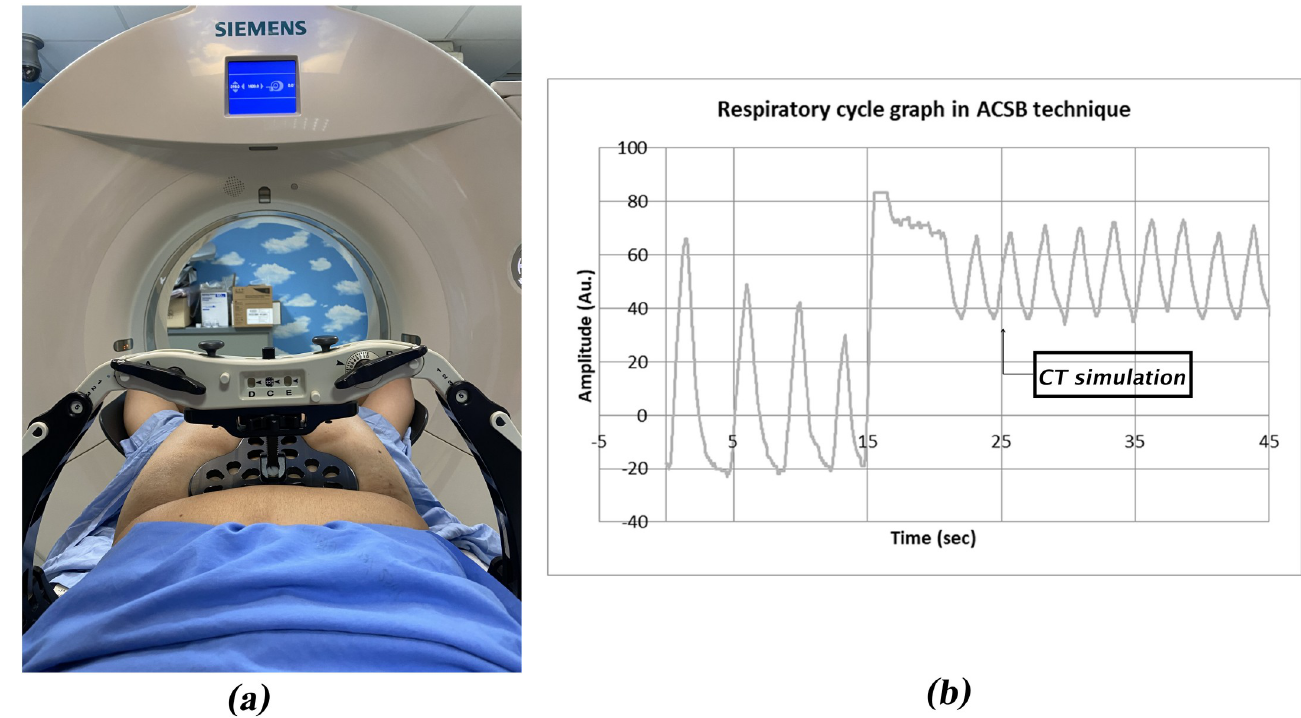
Fig 1. Compression devices in ACSB Technique (a) and Respiratory Cycle Graph